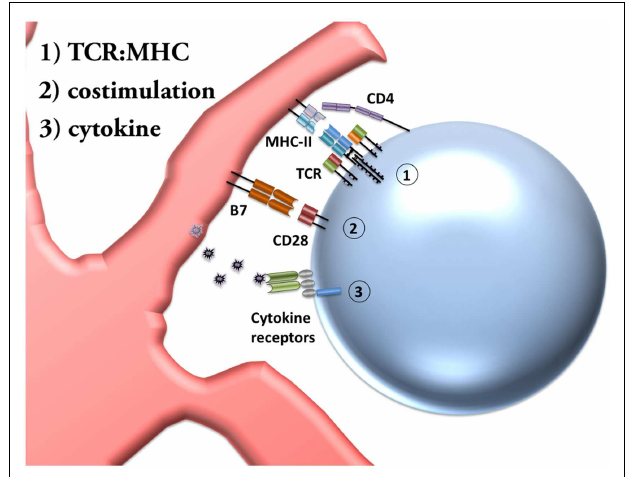
FIGURE 1 | Priming of CD4T cells requires three signals . Conventional activation of naïve CD4T cells requires three distinct signals. Signal 1: the TCR (T cell receptor) on theT cell must recognize a particular peptide sequence, processed within an APC (antigen presenting cell) and presented by MHC-II (major histocompatibility complex-II) in mice.The CD4 co-receptor shown stabilizes theT cell interaction with MHC-II. Signal 2: activated DCs (dendritic cells) upregulate the costimulatory molecules B7.1 and B7.2 (also called CD80 and CD86). CD28 onT cells recognize these costimulatory molecules as a second signal for activation. In the absence of costimulationT cells undergo anergy or death. Signal 3: the cytokine environment instructs the final stage ofT cell priming by determining the differentiation pathway undergone by the activatedT